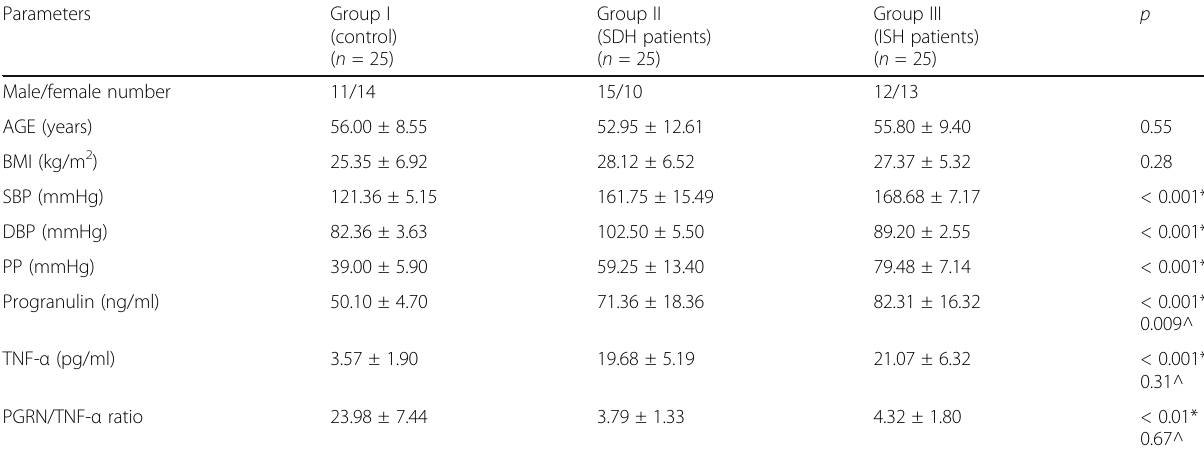
Table 1 Demographic, clinical, and biochemical characteristics of the subjects Parameters